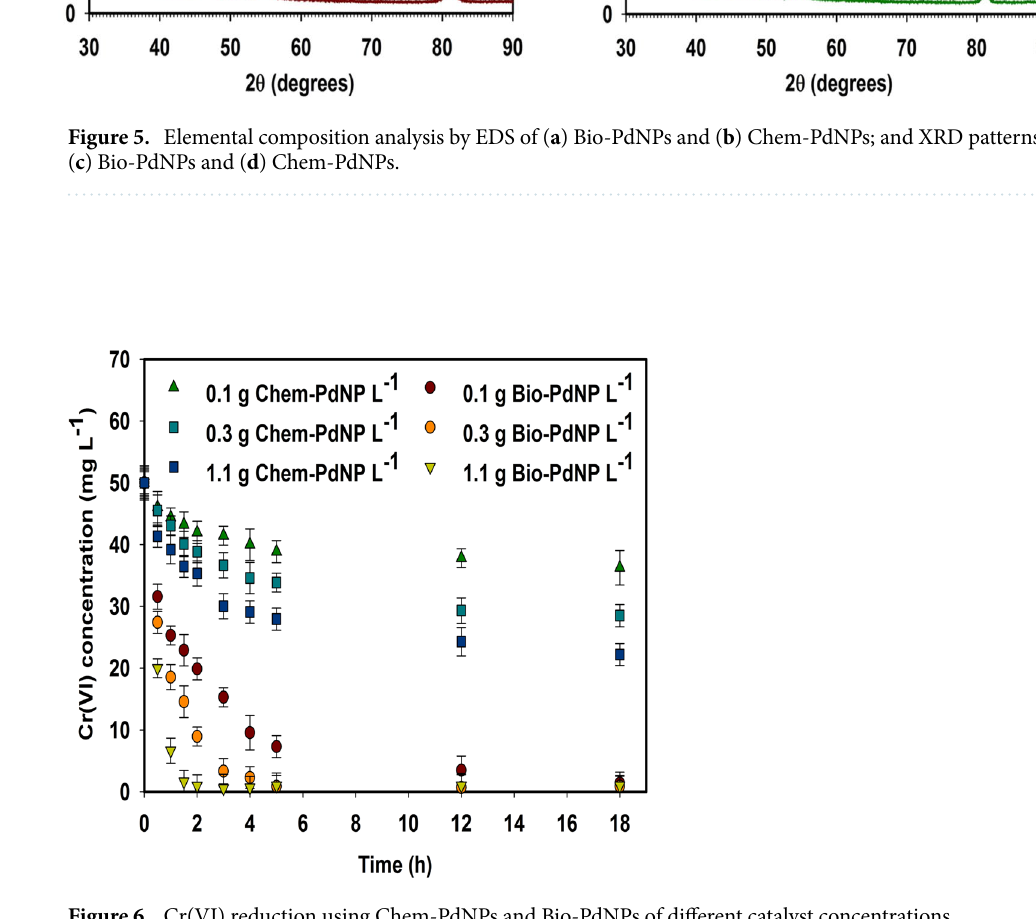
Figure 6. Cr(VI) reduction using Chem-PdNPs and Bio-PdNPs of different catalyst